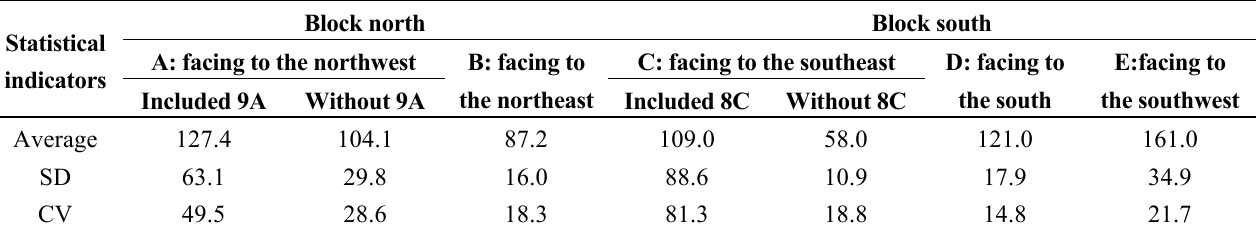
Table 4. Average and variability of heating historical annual consumption (kWh/m 2 ) according to orientation. Period 1996–2008 (To see Figure